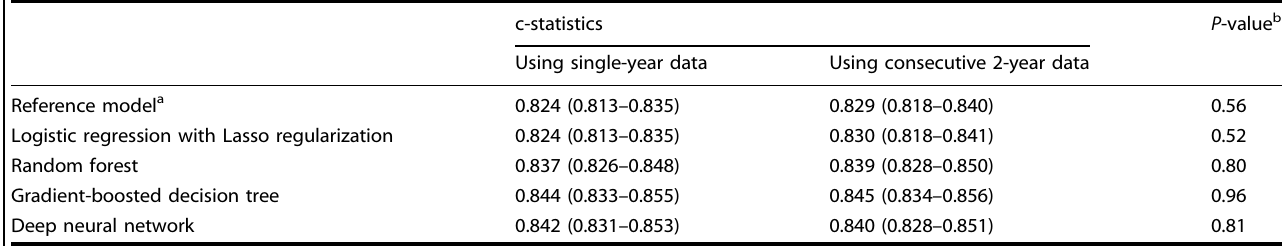
Table 5. Comparison of the prediction ability for HNHC patients between the model using single-year and consecutive 2-year